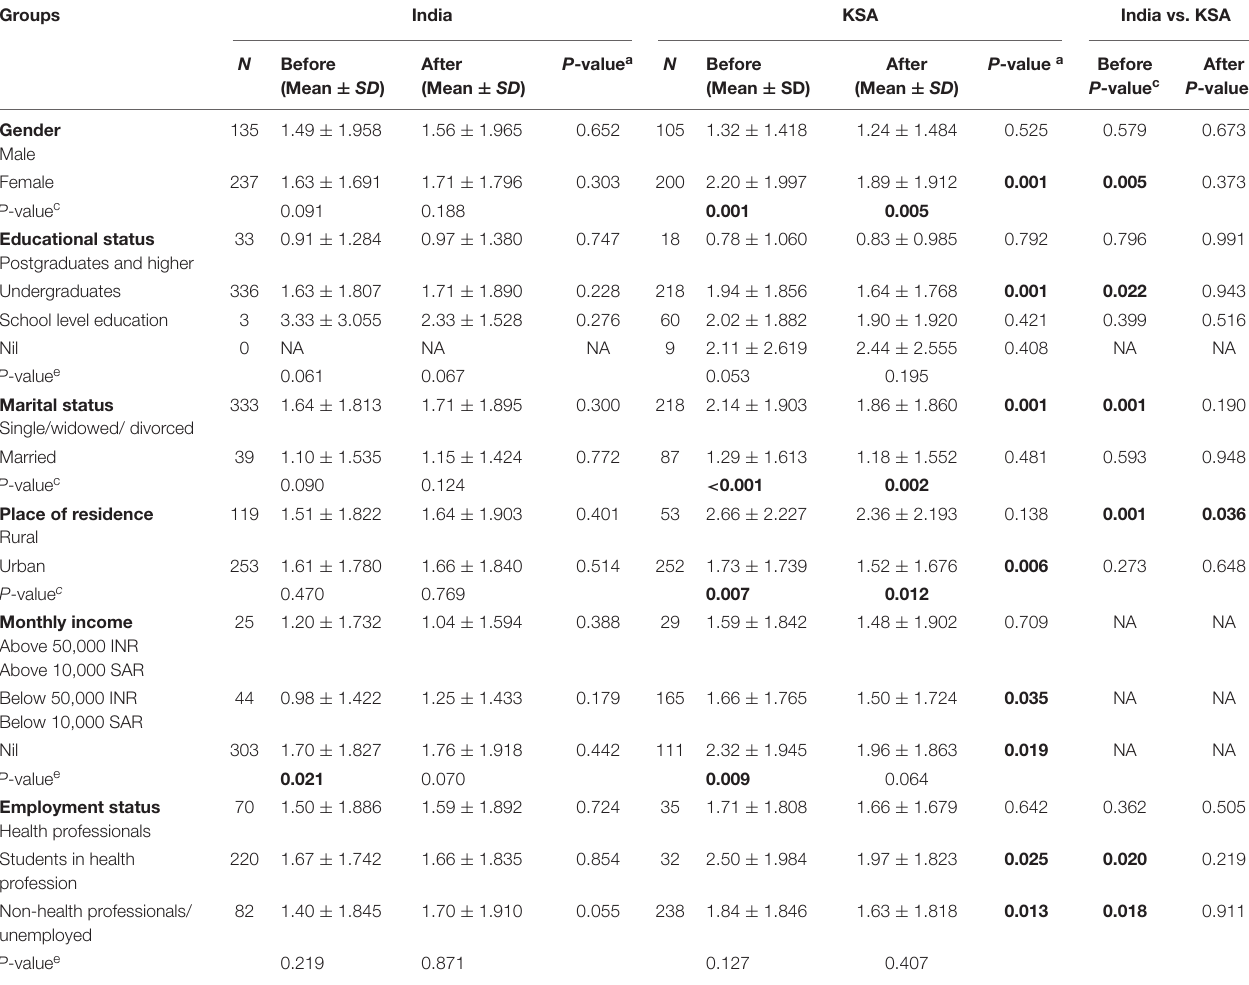
TABLE 3 | Comparison of anxiety symptoms stratified by sociodemographic variables before and after the advent of COVID-19 vaccines.